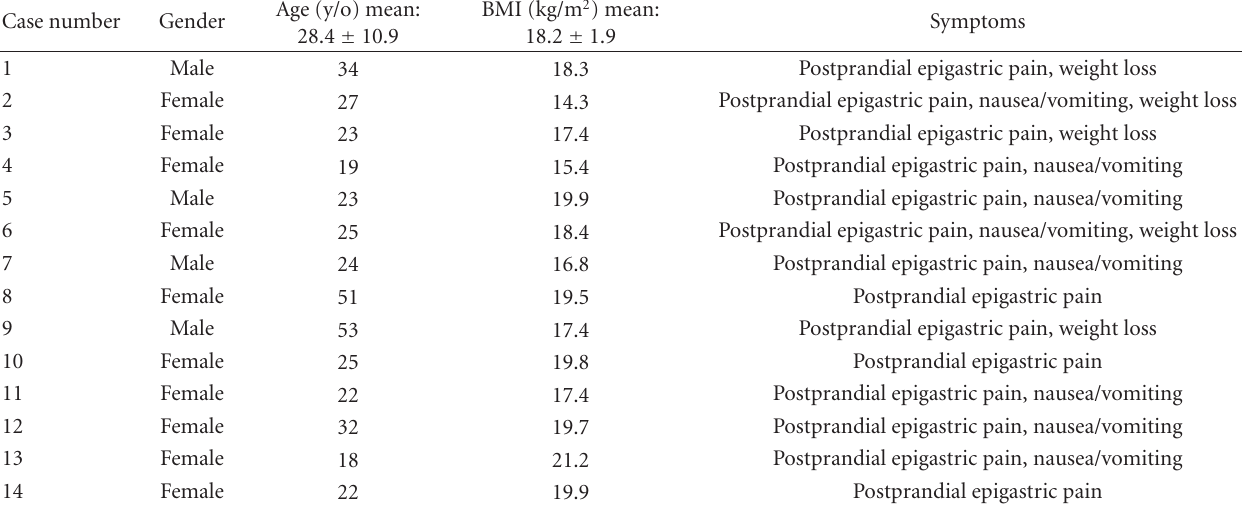
Table 1: The demographic and clinical characteristics of patients with celiac artery compression syndrome ( n = 14). Case number